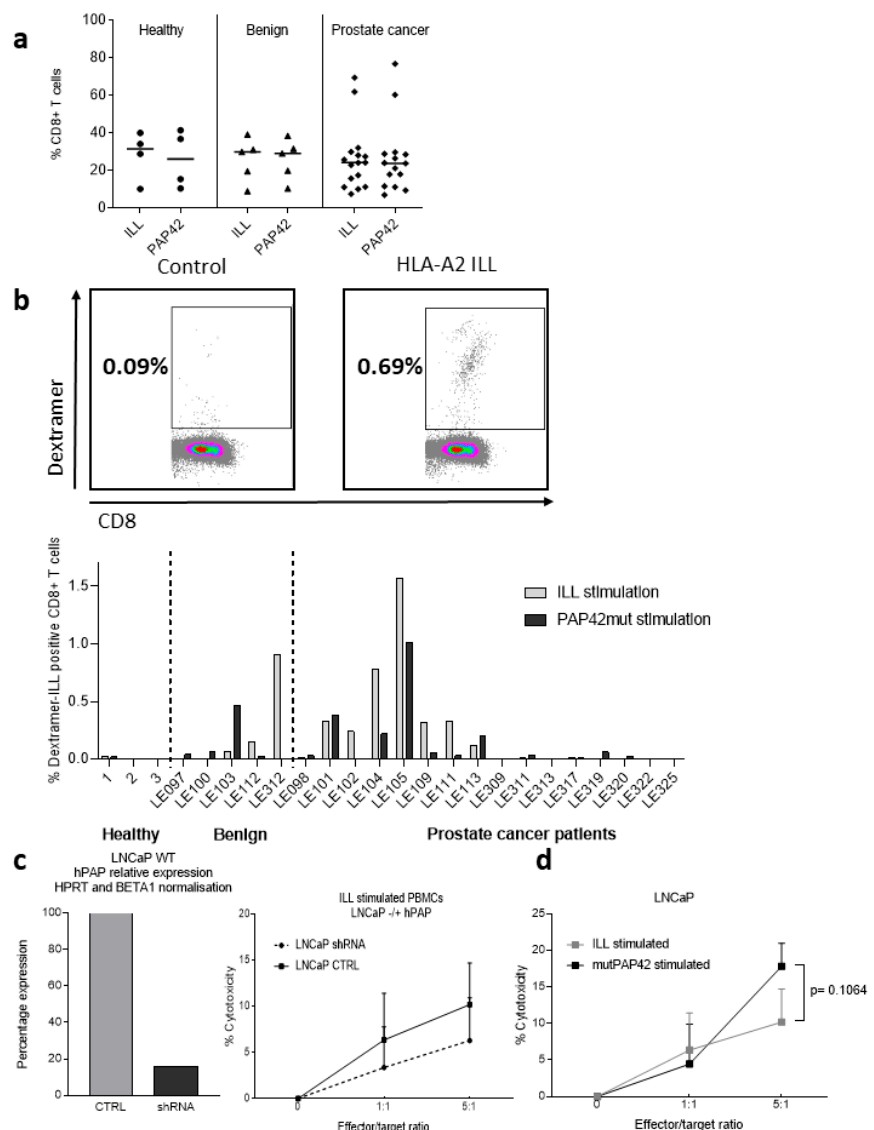
Figure 1. Presence of ILL-specific CD8 + T cells in the blood of patients with PCa. Cryopreserved PBMCs from HLA-A2 + individuals were cultured for 12 days in the presence of IL-2, IL-15, and either the ILL9mer peptide or the hPAP42mer-mutated peptide. Three groups were compared: healthy individuals, individuals with benign disease, and patients with PCa. On day 12, PBMCs were blocked with a human FcR block and then incubated with surface mAbs and the relevant Dextramer™. ( a ) Proportion of CD8 + T cells within total T cells, ( b ) gating example of Dextramer™- positive CD8 + T cells and proportion of Dextramer™-positive CD8 + T cells following each stimulating condition. ( c ) Cytotoxicity of ILL-stimulated PBMCs against PKH26-labeled WT or PAP low LNCaP cells was measured by flow cytometry. ( d ) Cytotoxicity against PKH26-labeled WT LNCaP cells was compared between each stimulating condition. No difference in the proportion of CD8 + T cells was observed between groups or stimulating conditions. ILL-specific CD8 + T cells were detected following ILL9mer peptide stimulation (benign:1/5, PCa: 6/16) and after hPAP42mer-mutated peptide stimulation (benign: 1/5, PCa: 4/16). Cytotoxicity against LNCaP cells was observed. Bars represent the mean percentage of positive cells and the errors bars represent the SD ( n = 3 to 16 patients per group). Dots represent the mean percentage of cytotoxicity and the errors bars represent the SED ( c ). Differences in the proportion of positive cells between groups were determined using a two-way ANOVA comparison